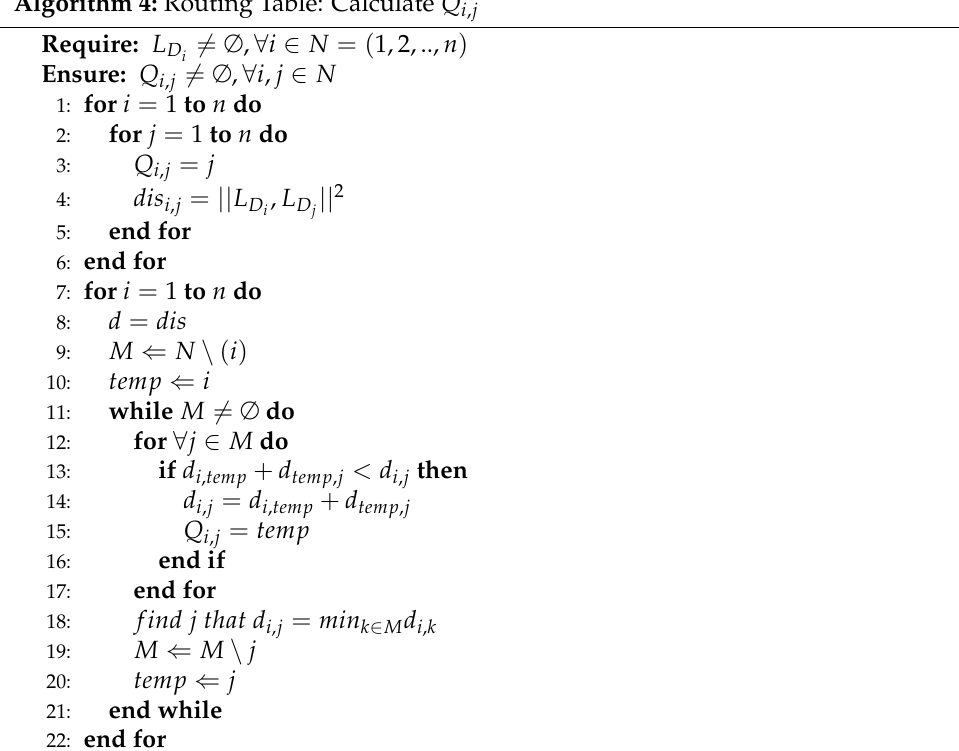
Algorithm 4: Routing Table: Calculate Q i ,